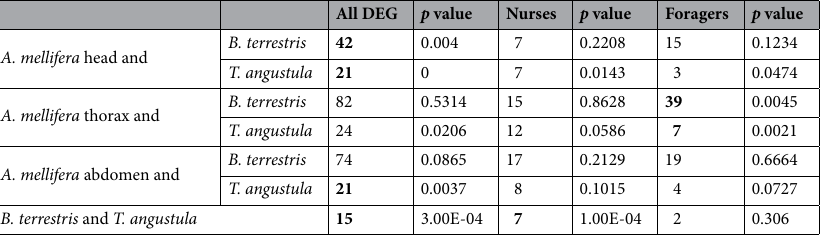
Figure S3): “metabolic process” (GO:0008152) and “cellular process” (GO:0009987). Notably, although specific enriched terms were distinct in both species (only “DNA integration” was commonly enriched), this divergence